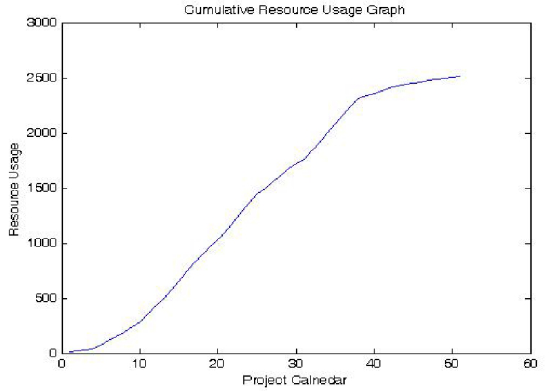
Figure 43. Cumulative resource usage for resource 1 of experiment 3 (after using forward